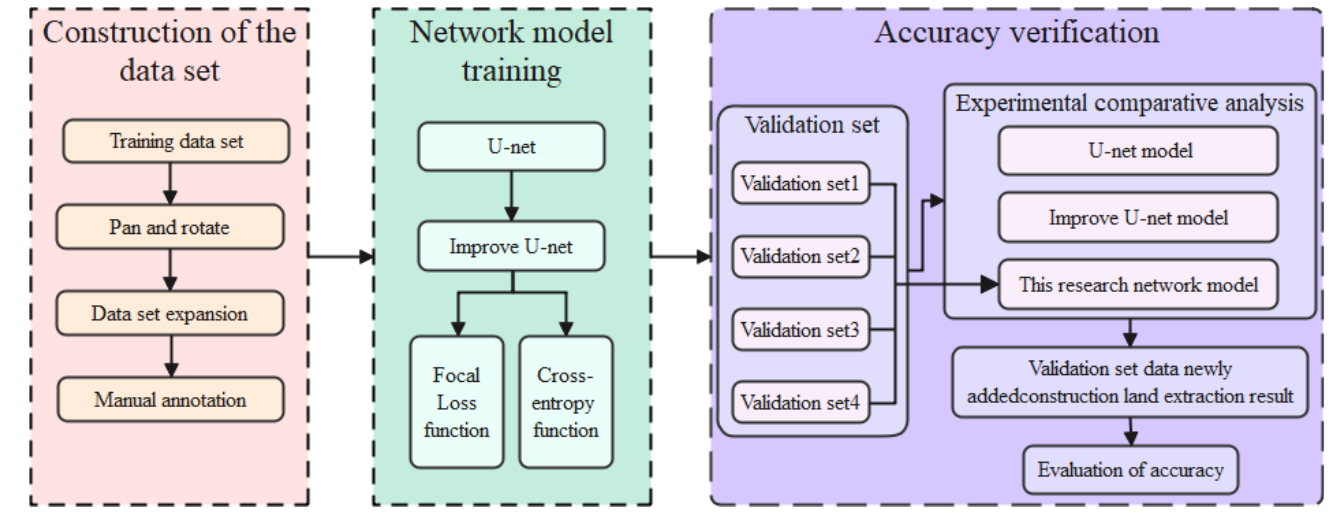
Figure 1. Technical flow